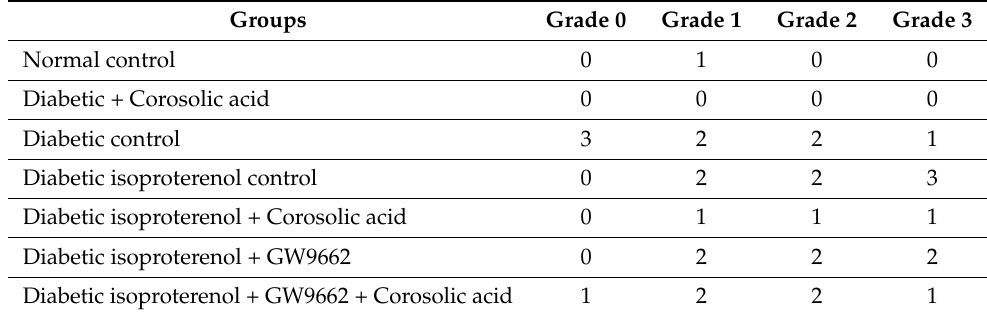
Table 2. The effect of corosolic acid on histopathological grades of myocardial injury in